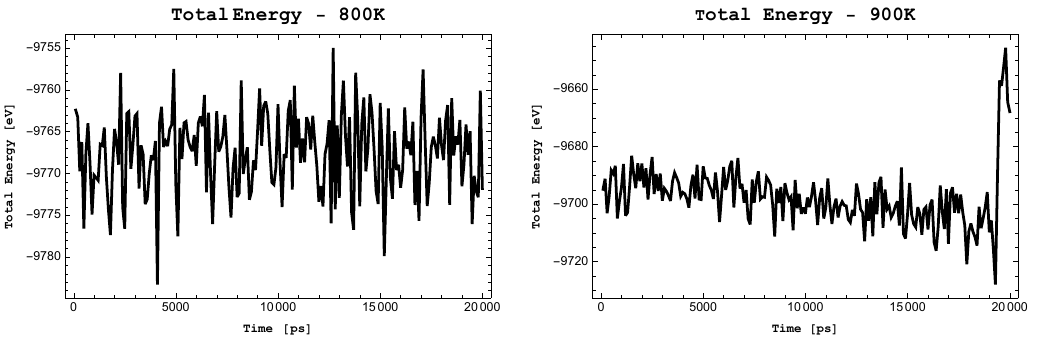
Figure 6. Anisotropic-cyclicgraphene —total energy for 800K and